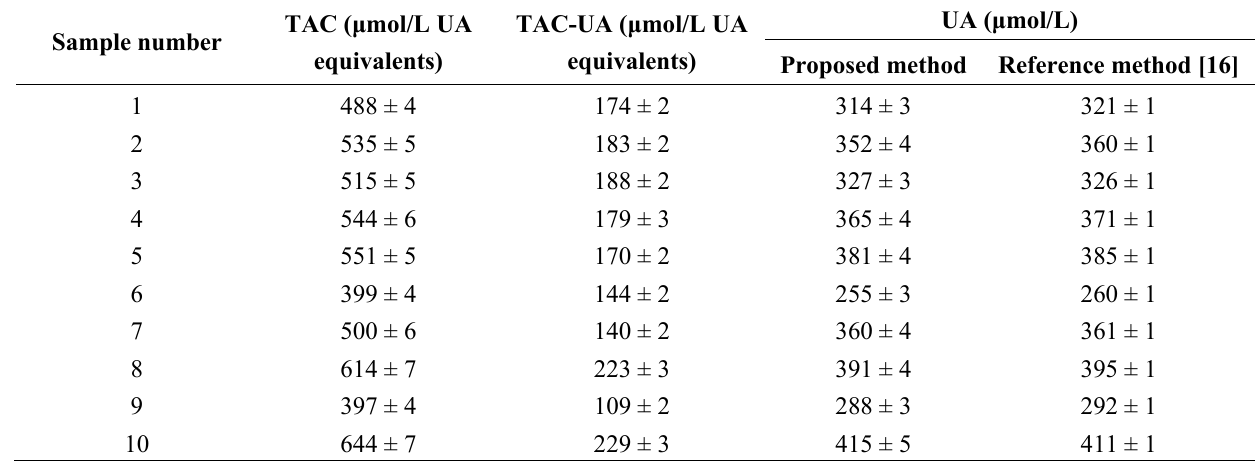
Table 2. Original data of TAC, TAC-UA and UA in our plasma samples. All data are expressed as means ± SD. All measurements for each sample were done in